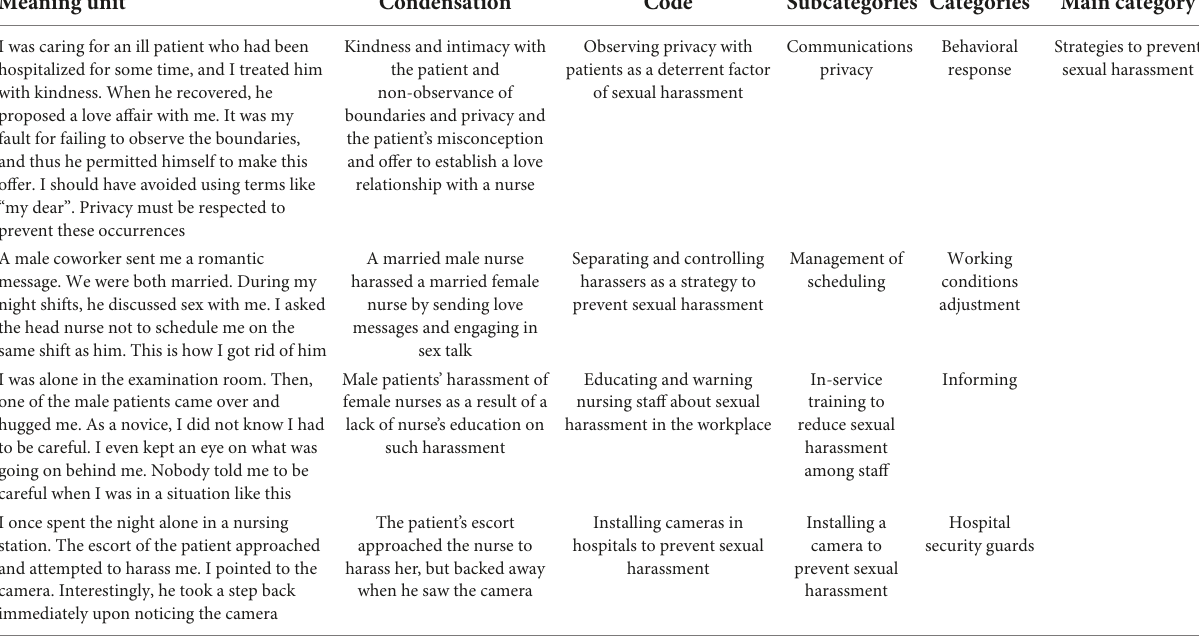
TABLE 3 Example of qualitative content analysis